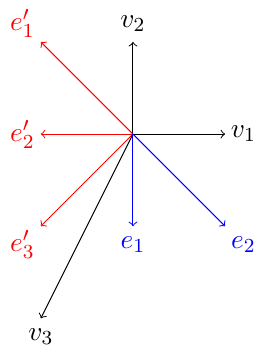
Figure 3 . A fan of a 2D toric base B . The fan has several 1D cones, each corresponding to a curve in Λ B = H 2 ( B, Z ) . The red and blue 1D cones, ending in vertices e 0 self-intersection, and may be shrunk simultaneously to provide two SCFT sectors Γ 1 , Γ 2